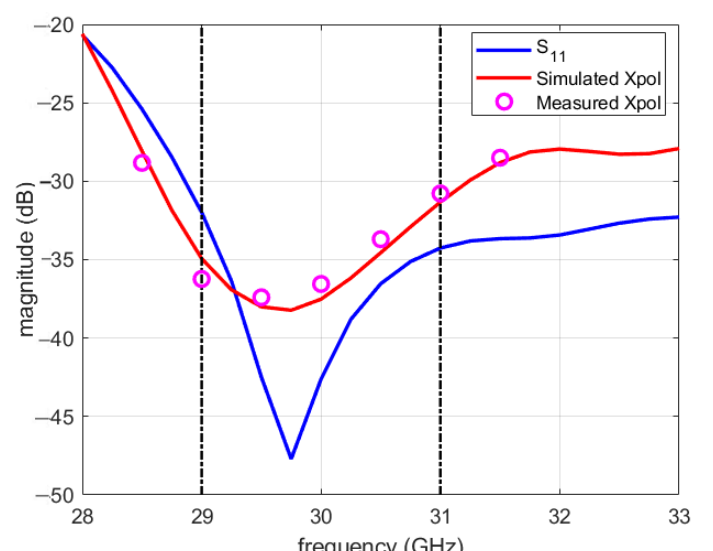
Figure 6. Designed horn: simulated frequency behavior of its reflection coefficient magnitude | S 11 | , simulated and measured cross-polarization level.